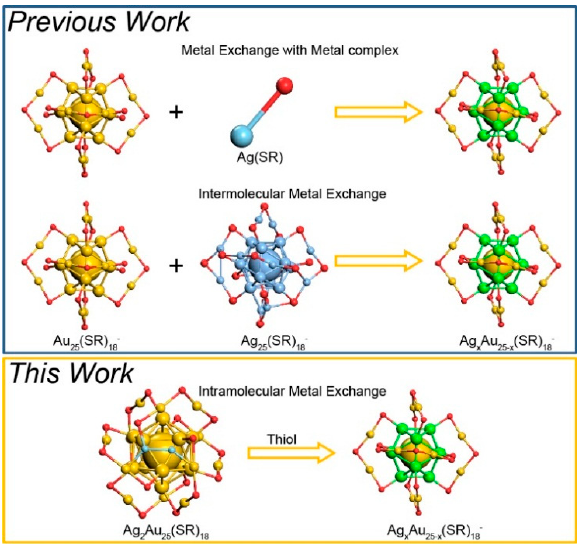
Figure 1. Synthesis of atomically precise alloy nanoclusters with different methods.